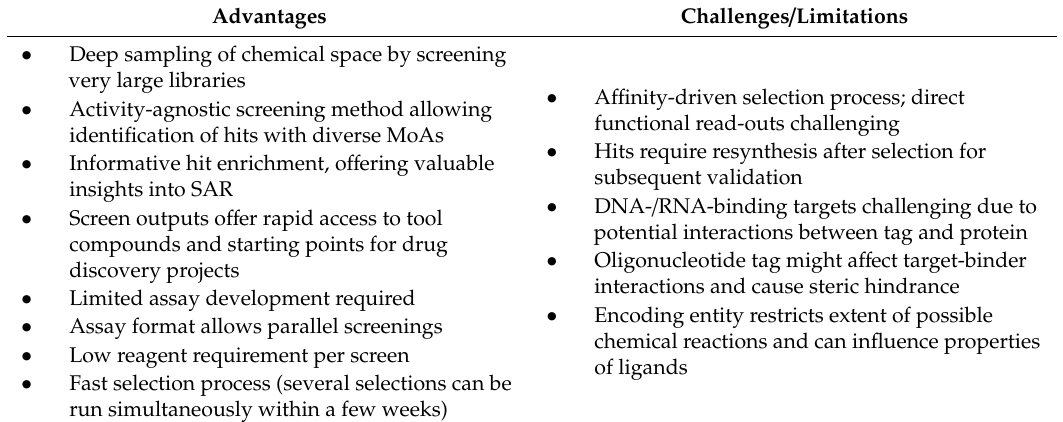
Table 1. Advantages and challenges / limitations of the ELT technology. Details on the key points are given in the main